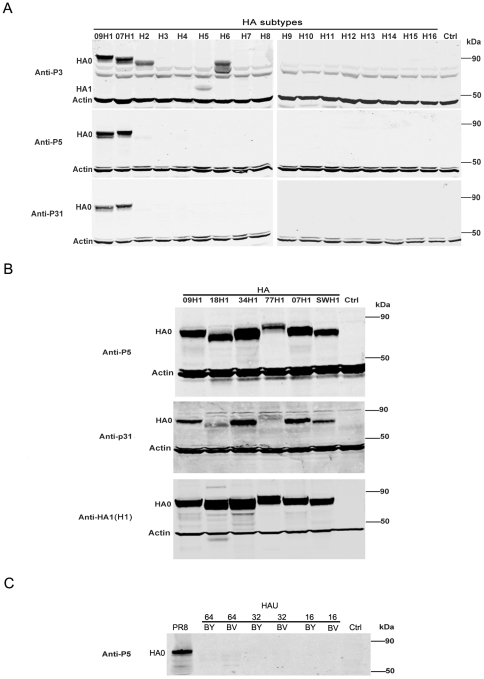
Specificity of antibodies induced by peptide conjugates.(A) Reactivities between antibodies against P3, P5 and P31 and H1–H16 HA proteins. Western blot analysis was performed using lysates from 293T cells transfected with the recombinant pCAGGS plasmids expressing H1–H16 HA proteins. For H1 subtype HA, HA proteins from a seasonal epidemic H1N1 strain A/Brisbane/59/2007 and an H1N1pdm strain (A/California/04/2009) were both tested. (B) Reactivities between antibodies against P3, P5 and P31 and HA proteins of H1 subtype strains. Western blot analysis was performed on 293T cell lysates expressing recombinant HA proteins from five human H1N1 strains isolated in different years (1918, 1934, 1977, 2007, 2009) and a swine H1N1 strain. 293T cells transfected with an empty vector was used as a control (Ctrl). β-actin was used as a loading control. For the backgrounds of various subtype IAV strains, see Fig. 4. (C) Reactivities between anti-P5 antibody and HA proteins of influenza B virus strains. Western blot analysis was performed using different hemagglutinating units (HAU) of influenza B virus strains B/hubeiwujiagang/158/2009 (BY) and B/heilongjianghulan/116/2010 (BV). An influenza A virus strain A/PR8/34 (H1N1) (PR8) was used as positive control. MDCK cells were used as a negative control (Ctrl).